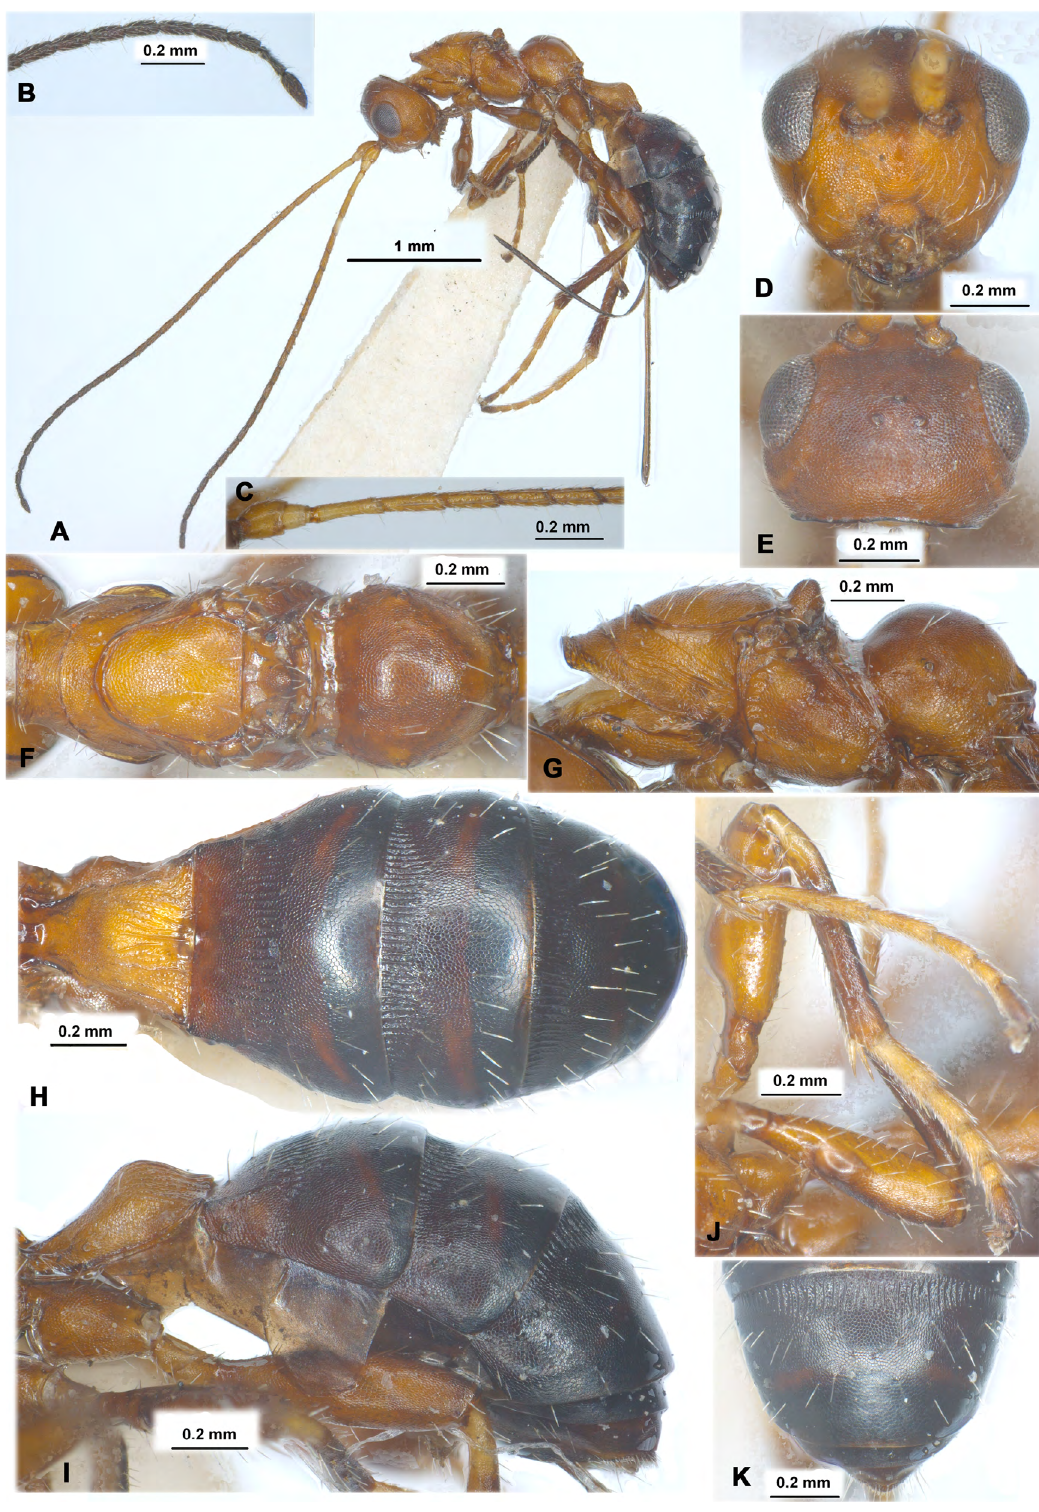
Fig. 46. Rhaconotus ( Rhaconotus ) formicoides (Marsh, 1965) comb. nov., ♀, holotype, USNM. A . Habitus, lateral view. B . Apical segments of antenna. C . Basal segments of antenna. D . Head, front view. E . Head, dorsal view. F . Mesosoma, dorsal view. G . Mesosoma, lateral view. H . Metasoma, dorsal view. I . Metasoma, lateral view. J . Hind leg. K . Apex of metasoma, dorsal